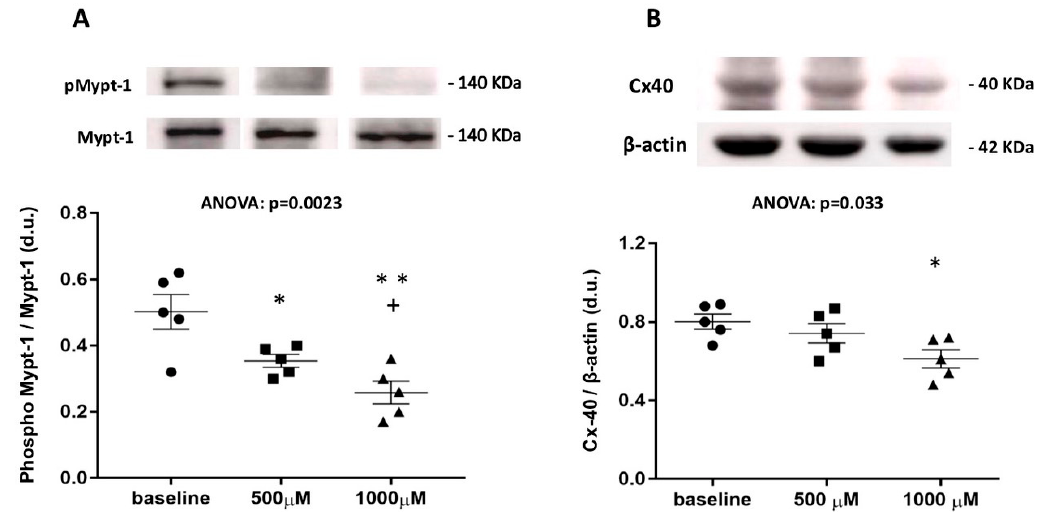
Figure 3. ( A ) Densitometric analysis of phospho-MYPT-1 in mononuclear cells of five DPAFs